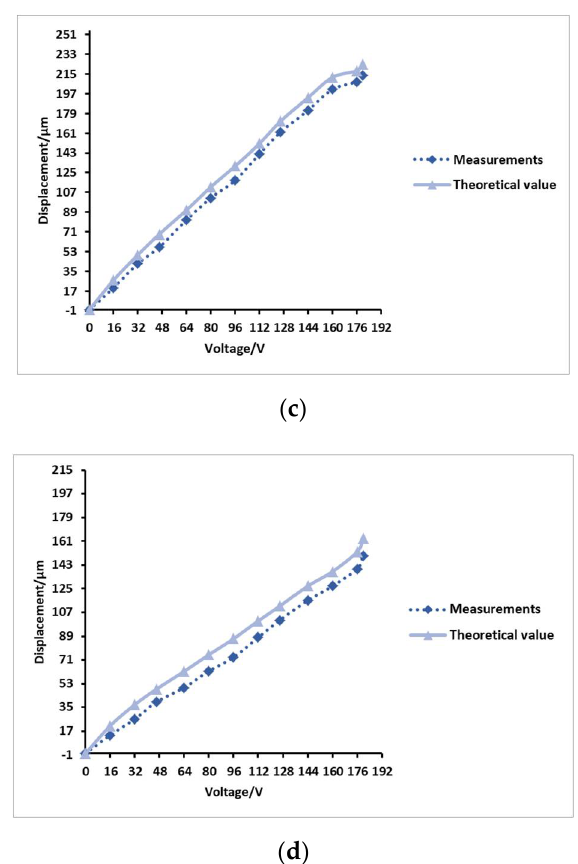
Figure 7. Comparative diagram of four sets of prototype drive voltages and flexible film displacement. ( a ) The relationship between the driving voltage of the No. 1 prototype and the displacement of the flexible film; ( b ) the relationship between the driving voltage of the No. 2 prototype and the displacement of the flexible film; ( c ) the relationship between the driving voltage of the No. 3 prototype and the displacement of the flexible film; ( d ) the relationship between the driving voltage of the No. 4 prototype and the displacement of the flexible film.